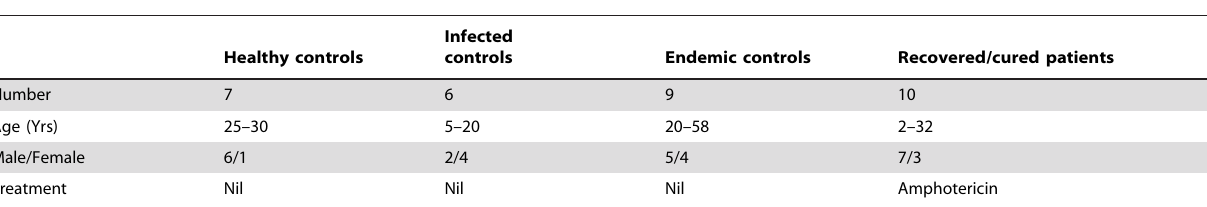
Table 1. Size and type of clinical samples taken for the study.